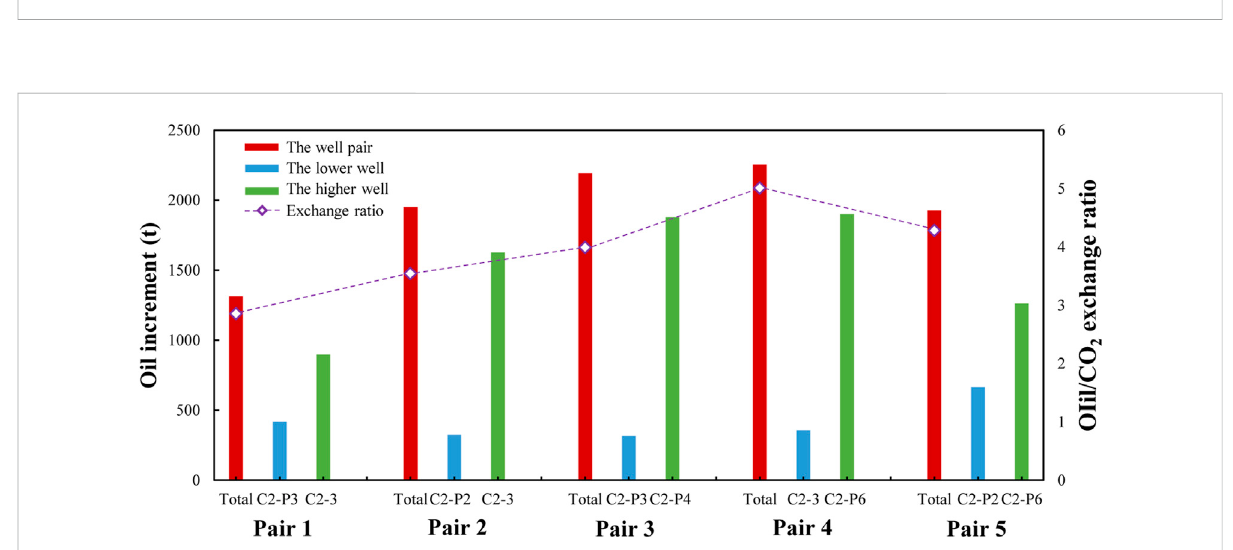
FIGURE 15 Oil increase and oil – CO 2 exchange ratio for fi ve well pairs using the well-to-well interplay of CO 2 huff-n-puff in pilot